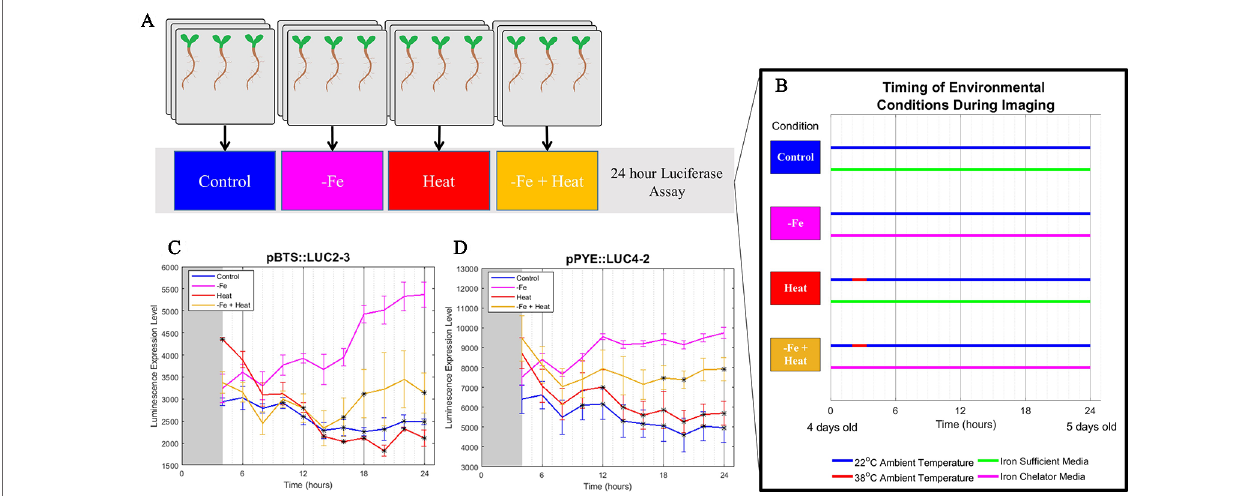
FIgURE 1 | Bioluminescence assay on POPEYE and BRUTUS. (A , B) A 24-h bioluminescence assay was performed to measure the expression levels of two major iron deficiency response genes POPEYE (PYE) and BRUTUS (BTS). Two lines each of pPYE::LUC (pPYE::LUC5-5 and pPYE::LUC4-2) and pBTS::LUC (pBTS::LUC5-1 and pBTS::LUC2-3) seedlings were grown on plates for 4 days and then exposed to Control, −Fe, Heat, or −Fe+Heat conditions (three biological replicates containing three seedlings for each condition). (C , D) Imaging began at 4 h and was conducted every 2 h following. These luminescence expression signals show that the expression of BRUTUS and POPEYE were suppressed over time when the seedlings were introduced to −Fe+Heat in comparison to −Fe (*p < 0.05 in comparison to the −Fe condition using a two-sample t-test). Here, lines pBTS::LUC2-3 and pPYE::LUC4-2 are shown, whereas supplementary material shows all four lines. Error bars show the standard error across biological replicates.